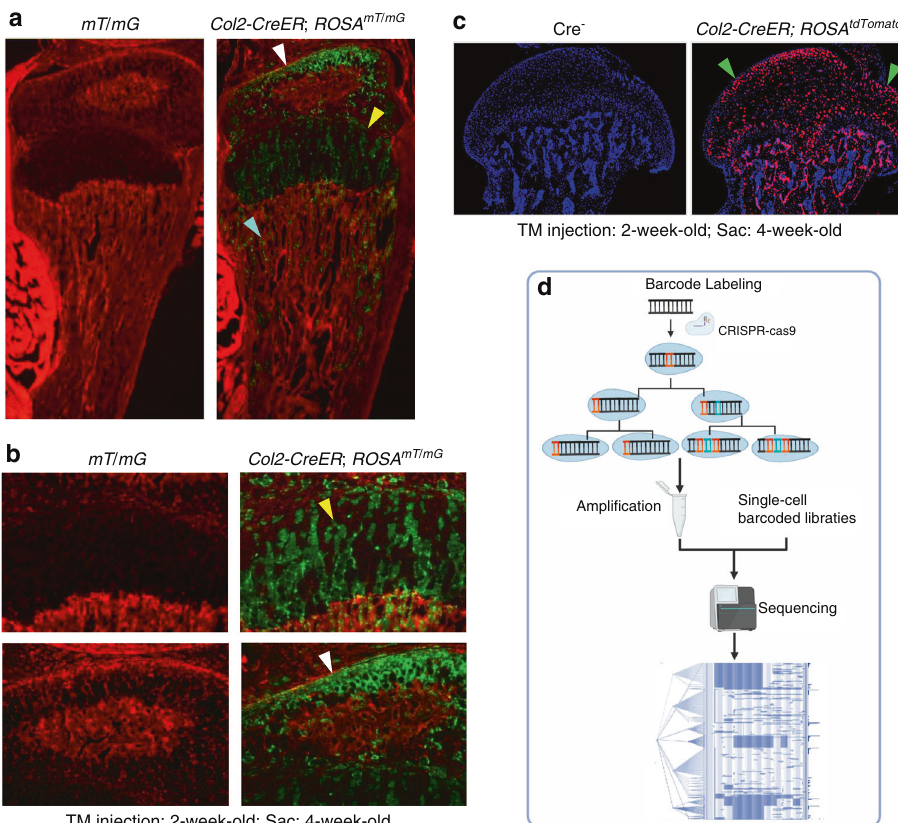
Fig. 4 Lineage tracing technique. a – c Col2-expressing cells label a subpopulation of chondrocytes which could migrate to bone marrow underneath the growth plate and transdifferentiate into progenitor cells. a Col2-CreER mice were generated and bred with ROSA mT/mG reporter mice or ROSA tdTomato reporter mice. b Tamoxifen was intraperitoneally injected to the 2-week-old Col2-CreER; ROSA mT/mG mice or Col2-CreER; ROSA tdTomato mice for 5 consecutive days (1 mg per 10 g body weight) and mice were sacri fi ced at 4-week-old. c Col2-expressing cells were detected in articular chondrocytes, growth plate chondrocytes and cells located in bone marrow underneath the growth plate. d DNA barcoding technology was used for cell lineage tracing. Figure 4a, b 256 and Fig. 4c 257 were cited from our previous